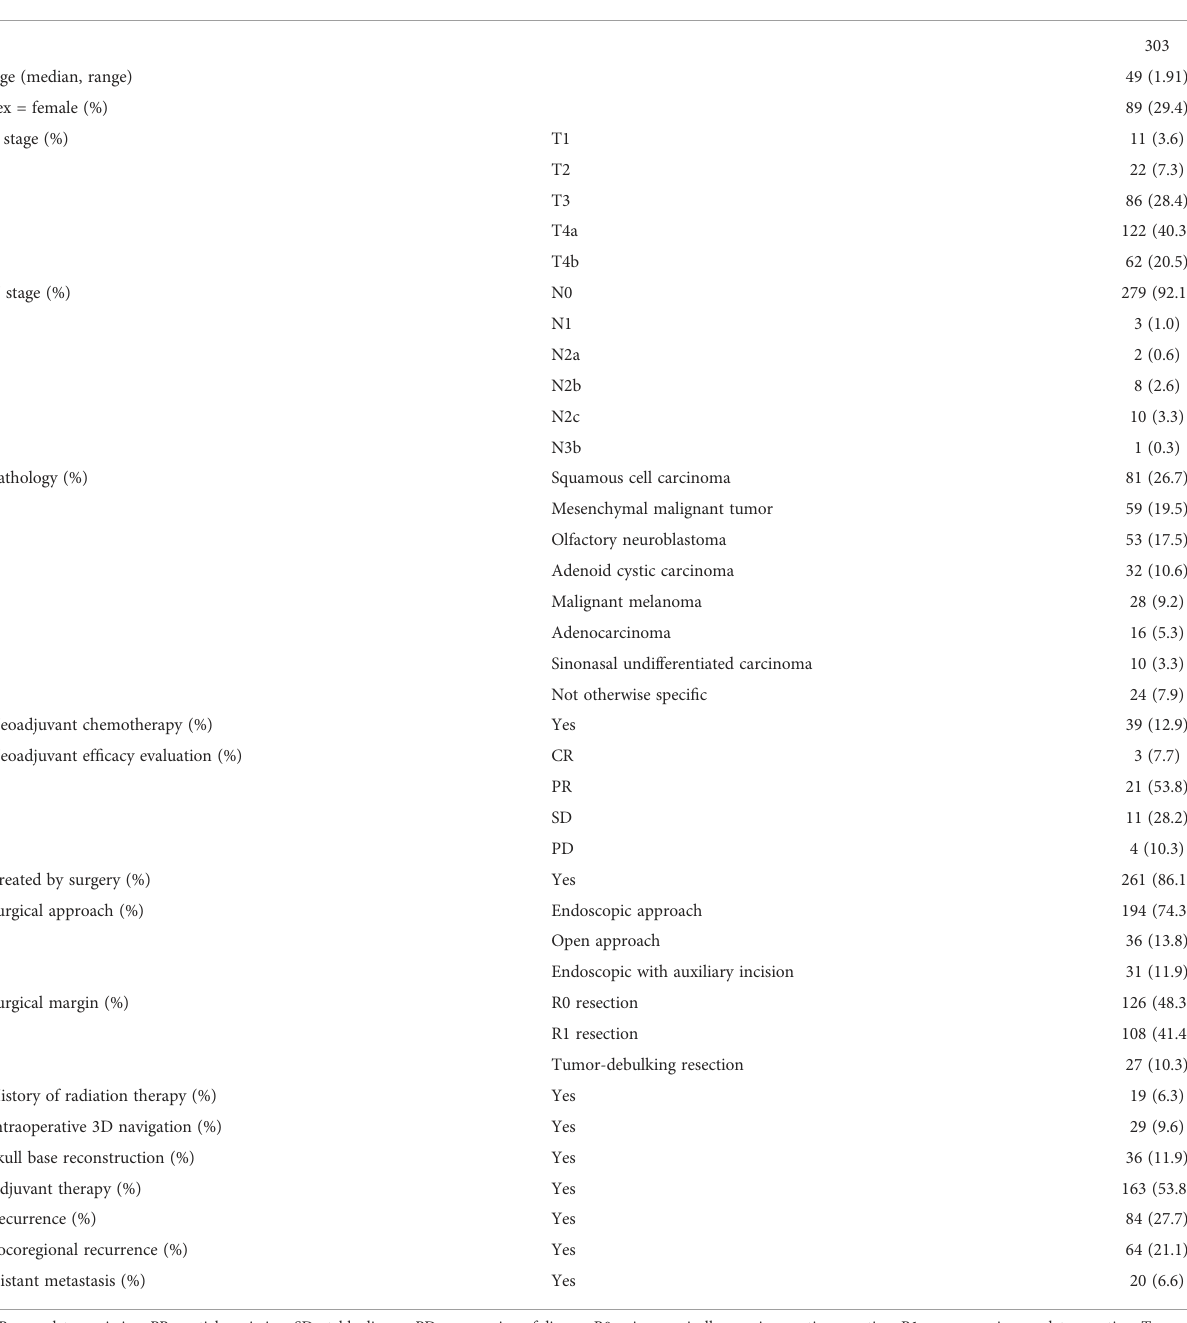
TABLE 1 Patient characteristics of sinonasal malignancy.